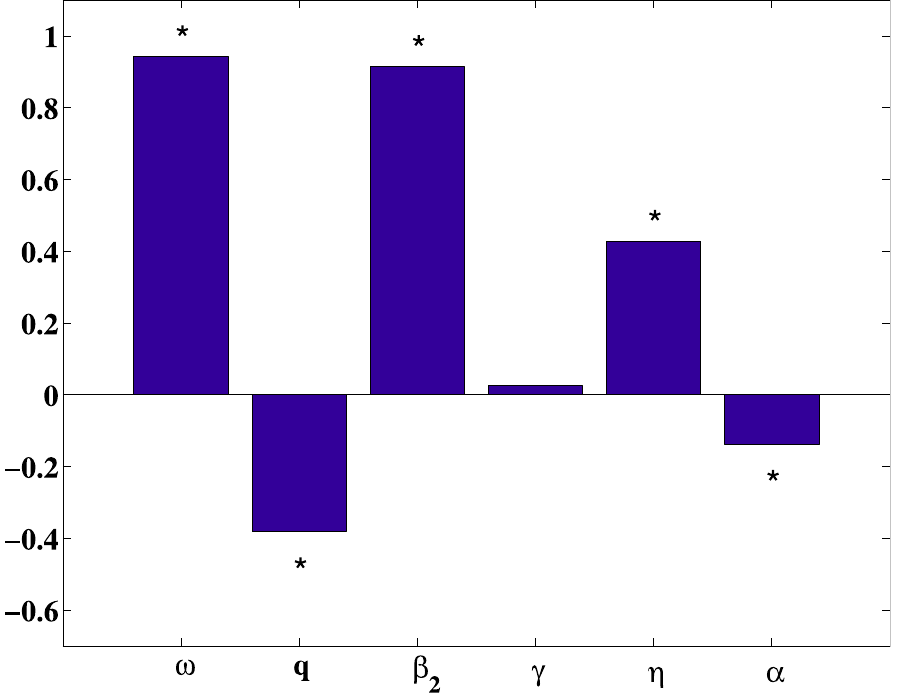
Fig 6. Partial rank correlation coefficients(PRCC) results for the dependence of σ on each parameter. * denotes the value of PRCC is not zero significantly, where the significance level is